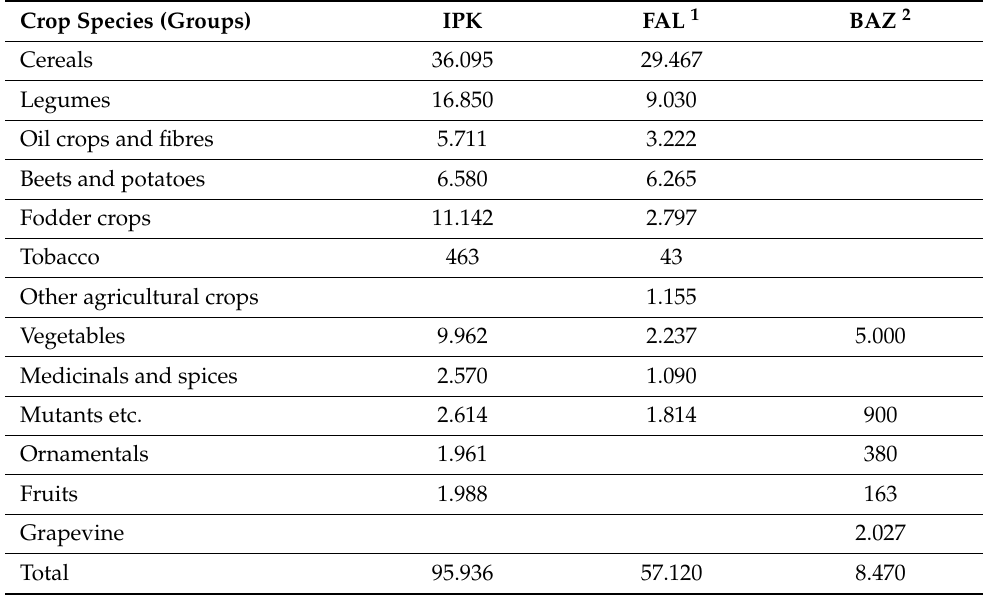
Table 2. Most important genebank collections in Germany at IPK, FAL, and BAZ in 1992